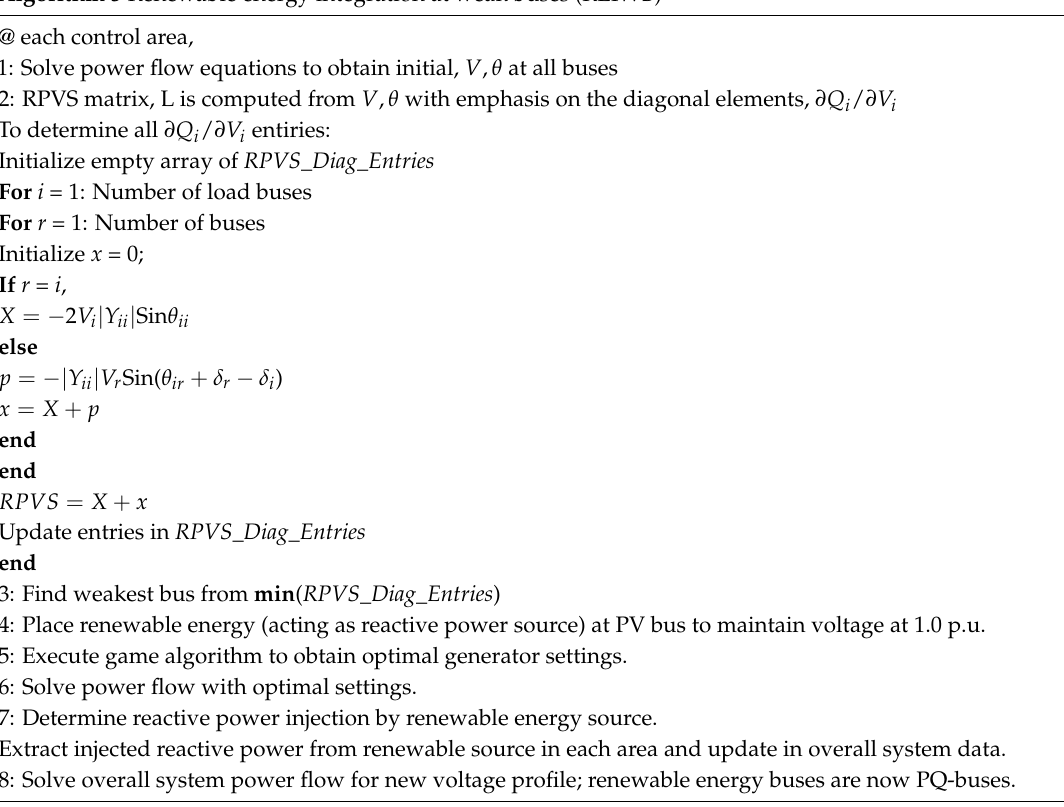
Algorithm 3 Renewable energy integration at weak buses (REIWB)